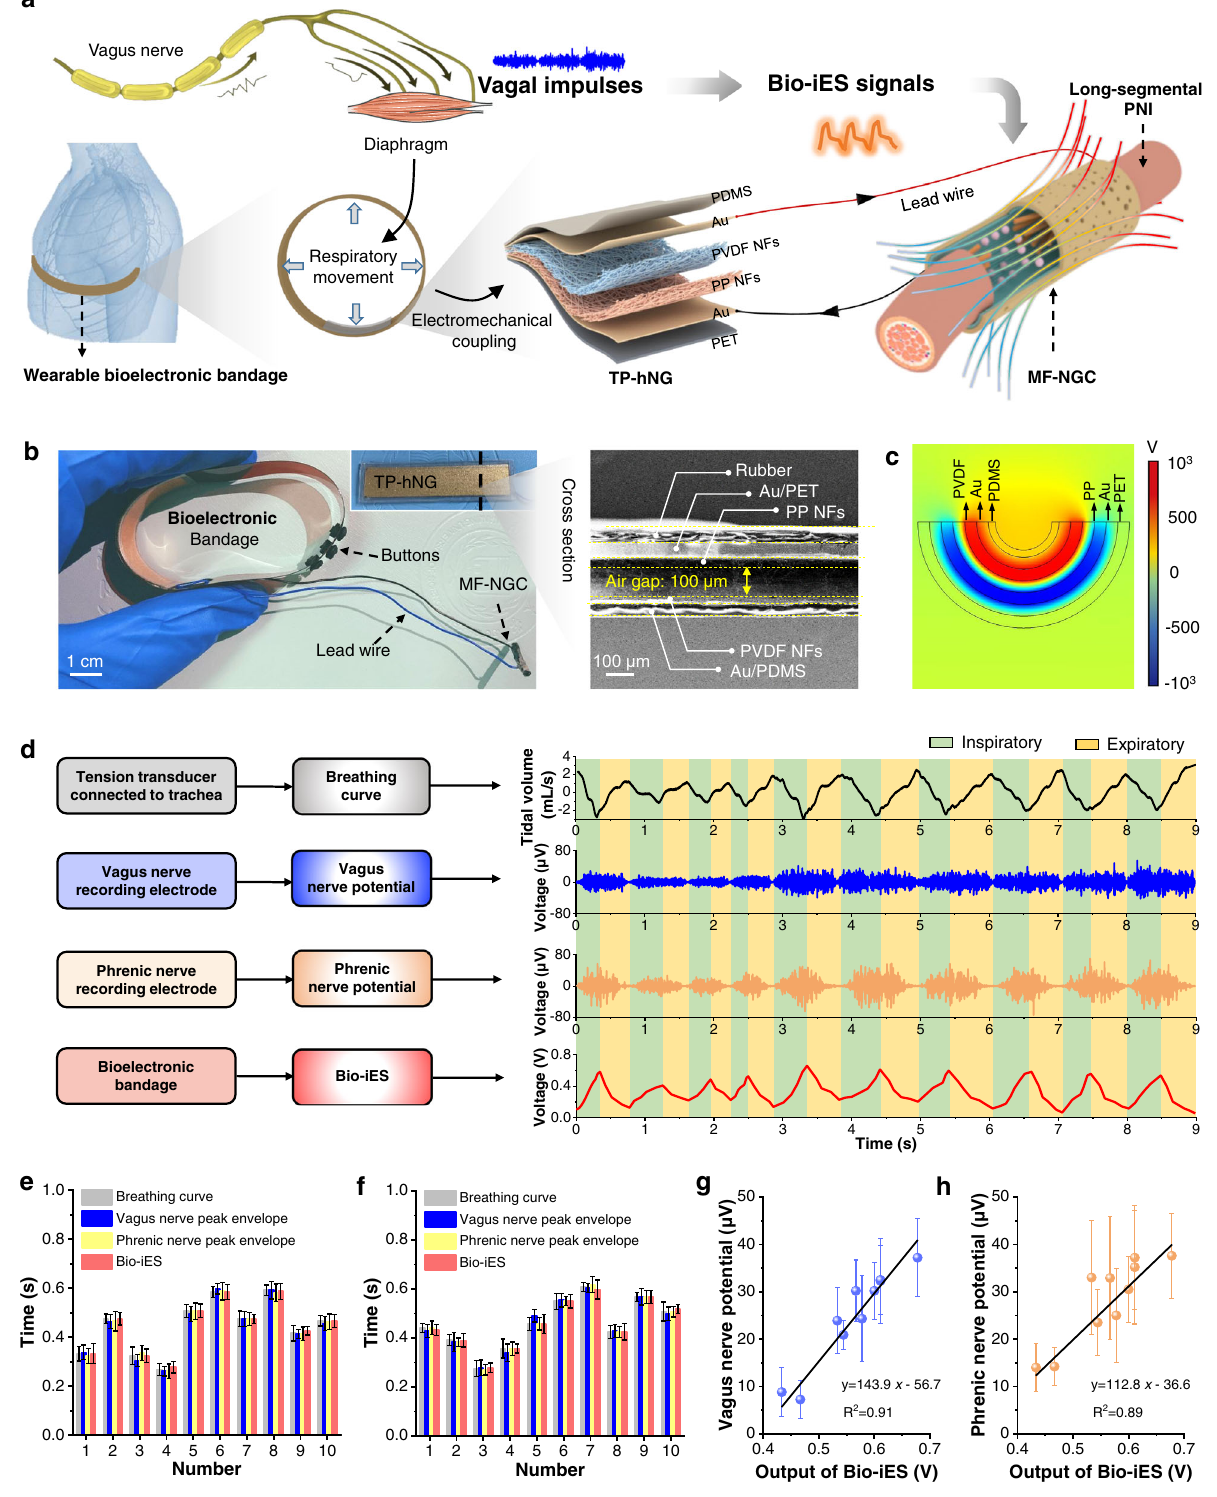
Fig. 1 | Construction ofbioelectronic bandage and validation ofits correlation with respiratory tract vagus nerve impulses. a Schematic diagram of working principle converting respiratory movement into real-time Bio-iES signals synchro- nized with vagus nerve impulses peak envelope, and the Bio-iES is transmitted to the defected nerve through MF-NGC. b Optical image of bioelectronic bandage showed miniaturization and fl exibility. SEM image displayed a cross-section of bioelectronic bandages. c FEA analysis of potential generated in TP-hNG. d Synchronism measurement between Bio-iES signals (red line) and vagus (blue